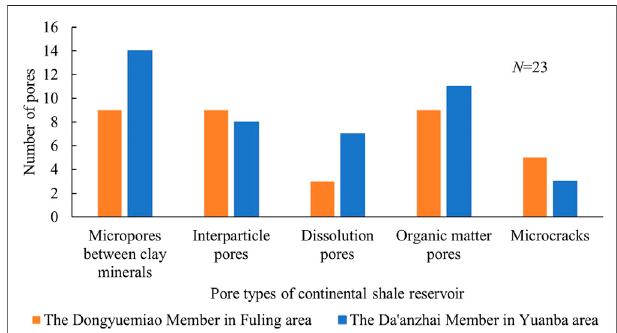
Frontiers in Earth Science |